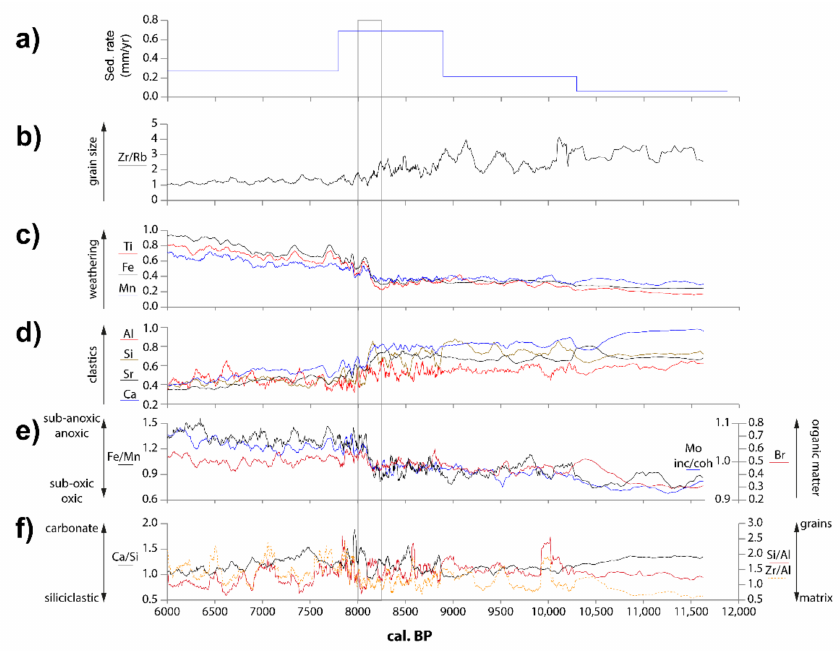
Figure 4. Age plot for the 12–6 ka BP period of the ( a ) sedimentation rate and ( b – f ) selected geochemical elements and